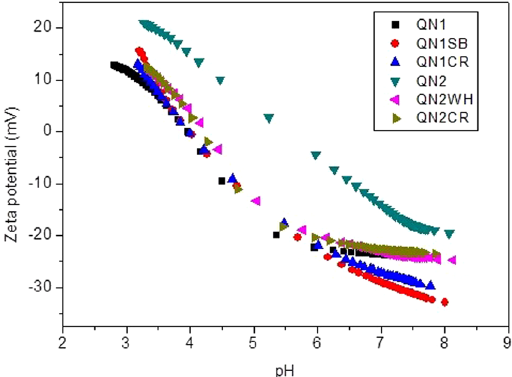
Figure 3. Zeta potentials of the soils and mixtures (soil + biochar): QN1 = quartzarenic neosol soil 1; QN1SB = quartzarenic neosol soil 1 + sugarcane bagasse biochar; QN1CR = quartzarenic neosol soil 1 + charcoal fines; QN2 = quartzarenic neosol soil 2; QN2WH = quartzarenic neosol soil 2 + water hyacinth biochar; QN2CR = quartzarenic neosol soil 2 + charcoal fines.